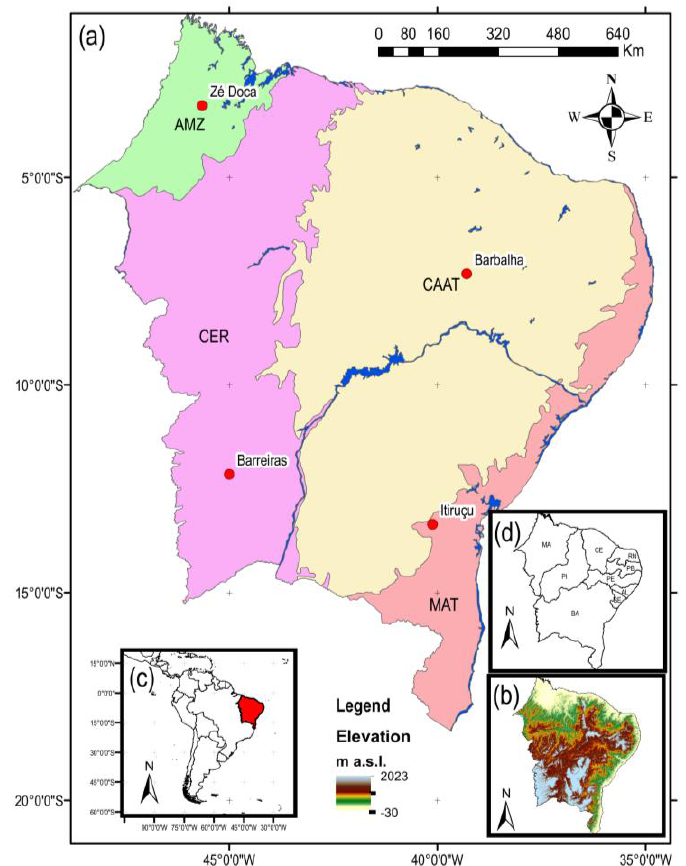
Figure 1. Geographical location of the study area: ( a ) NEB’s main biomes: AMZ, Amazônia; CER, Cerrado; MAT, Mata Atlântica; and CAAT, Caatinga. Circles denote the location of benchmark stations shown in Table 1; ( b ) NEB’s terrain elevation. Elevation based on 90 m DEM-SRTM images (available online at https://earthexplorer.usgs.gov); ( c ) NEB’s location in South America; ( d ) NEB’s states: MA, Maranhão; PI, Piauí; CE, Ceará; RN, Rio Grande do Norte; PA, Paraíba; PE, Pernambuco; AL, Alagoas; SE, Sergipe; and BA, Bahia. The scale bar refers to the center of the map. Table 1. Main characteristics of the biomes in NEB: Area (km 2 ), average elevation (m a.s.l.), average slope (%), Mean Annual Rainfall (MAR), and Mean Annual Temperature (MAT).